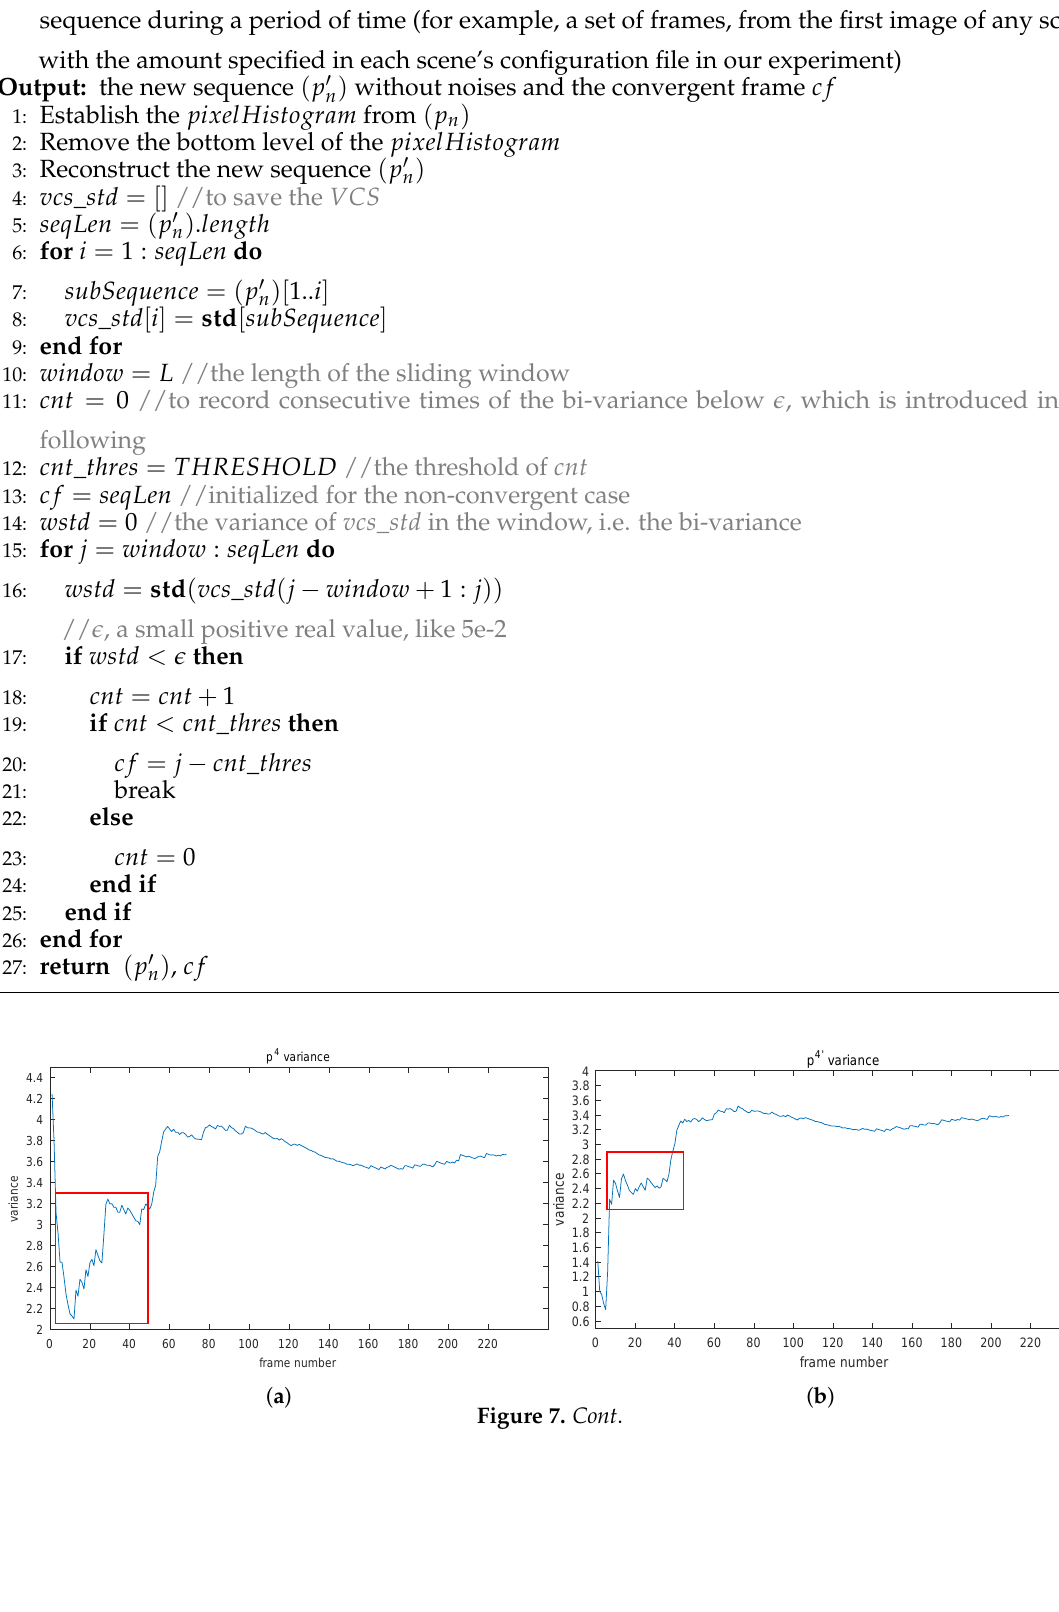
Algorithm 1 The implementation of bi-variance and NoIV-1.